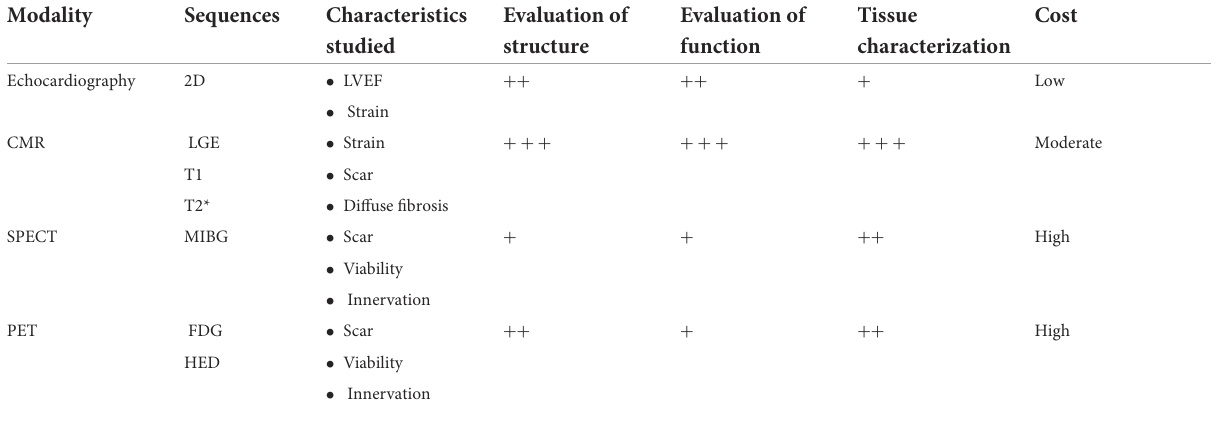
TABLE 1 Comparison of imaging modalities described in this